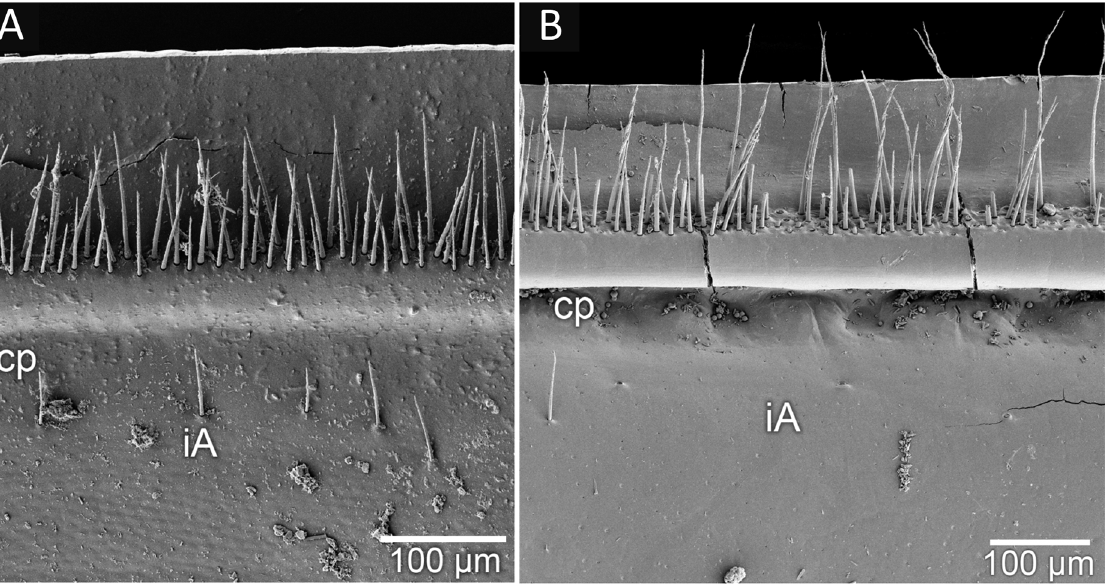
Fig. 6. Endoterga of midbody tergites, scanning electron micrographs. A . Sphaerobelum aesculus Rosenmejer & Wesener sp. nov., holotype (NHMD 621693). B . Zephronia viridisoma Rosenmejer & Wesener sp. nov., holotype, ♂ (NHMD 621695). Abbreviations: cp = cuticular patterns; iA = inner